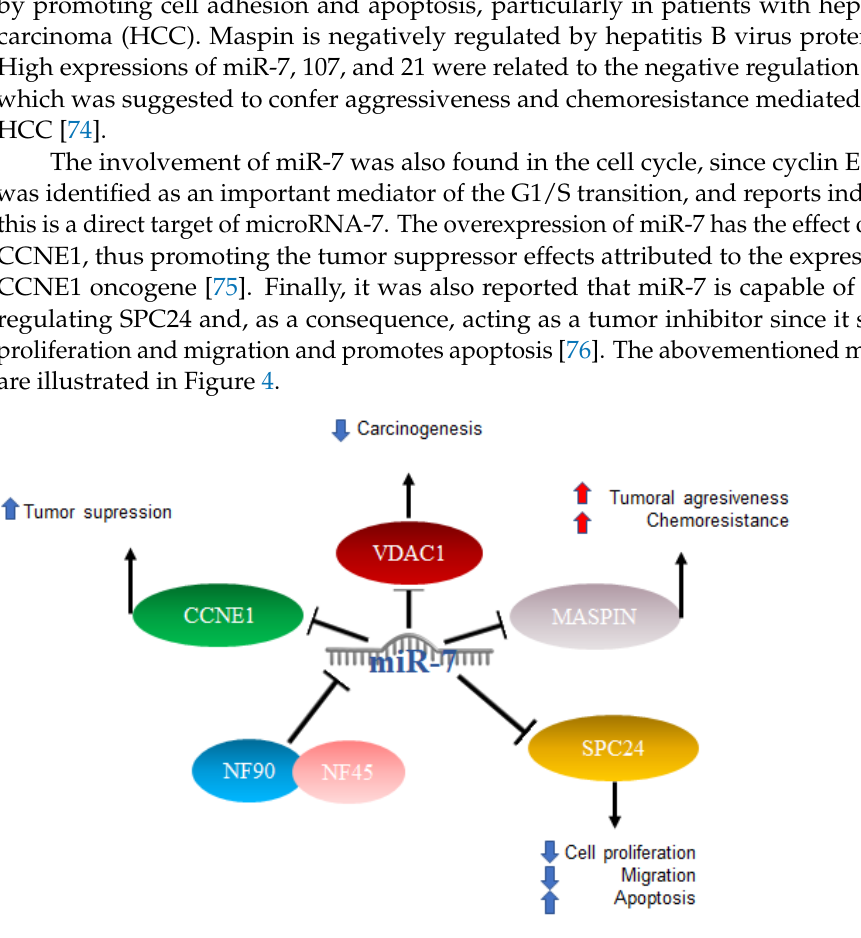
Figure 4. Role of miR-7 in hepatocellular cancer. Schematic representation of protein interactions and roles of miR-7 and its biological consequences in hepatocellular cancer.